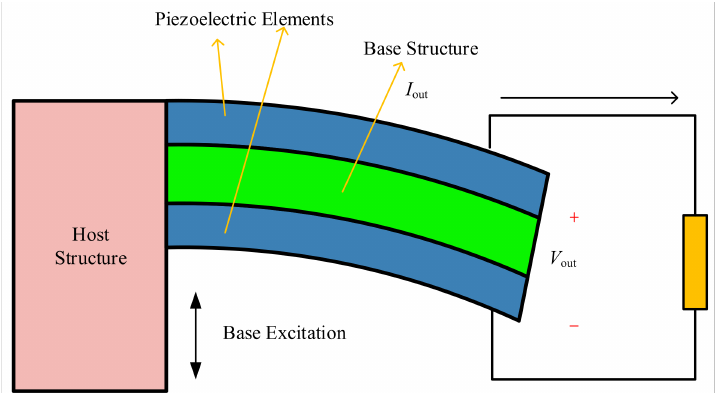
Figure 10. Schematic diagram of a typical PVEH. The bimorph structure of the PVEH is only for demonstration